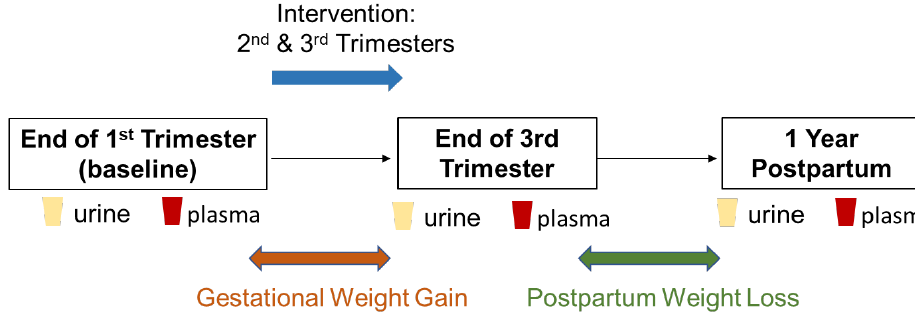
Figure 5. Overview of the study design workflow. Table 2. Characteristics of study volunteers. Summary statistics of the subsample of the MOMFIT trial (114 individuals: 50 control and 64 intervention) included in the metabolic profiling study. Values represent means and standard errors, and p -values (calculated through 2- tailed Student’s t test).